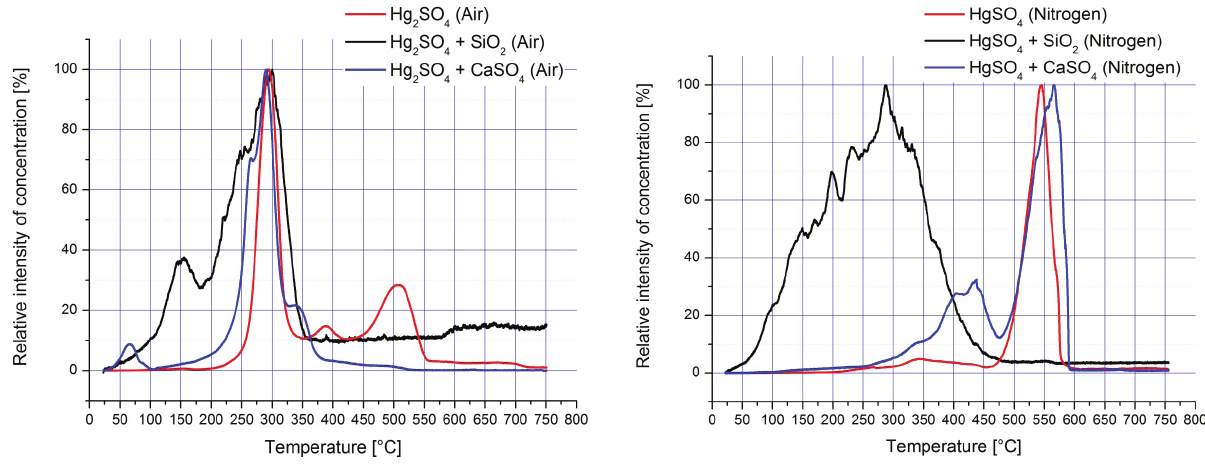
, purged with nitrogen. 4